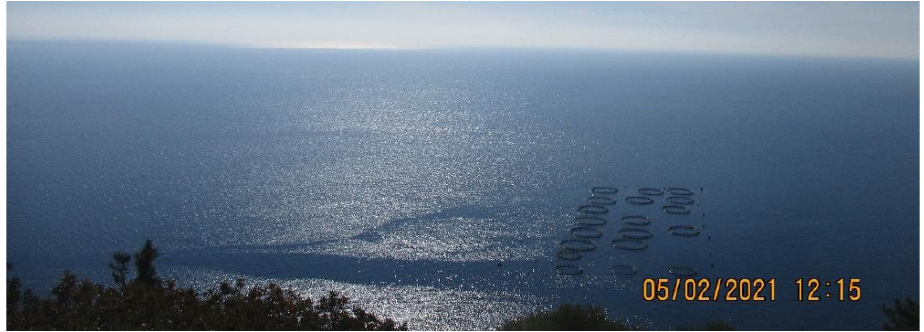
Figure 1. Biogenic oil film detected in photograph captured from land on 05.02.2021, 12:15 (EET) .